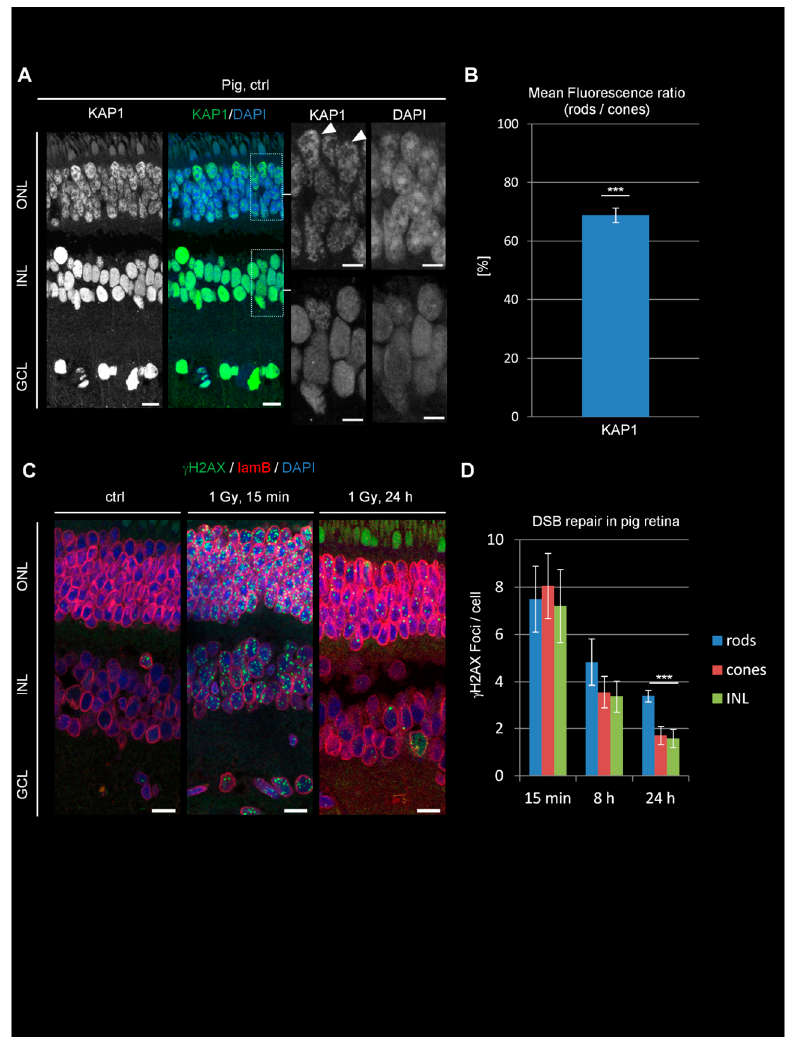
Figure 3. KAP1 expression and DSB repair in pig retinae. ( A ) Immunofluorescence images of KAP1 (green) in pig retinae. Nuclei were counterstained with DAPI (blue). Arrowheads in the enlarged pictures show cone PRs. Scale bars represent 10 μ m in whole retina and 5 μ m in enlarged pictures. ( B ) Quantification of the KAP1 signal in the nuclei of rods compared to cones. ( C ) Immunofluorescence images of radiation-induced γ H2AX foci (green) and lamin B (red) in ctrl and irradiated pig retinae at 15 min and 24 h after 1 Gy. Nuclei were counterstained with DAPI (blue). Scale bars represent 15 μ m. ( D ) Quantification of residual IR-induced γ H2AX foci in rods, cones, and INL cells at 15 min, 8 h, and 24 h after 1 Gy irradiation. Data are presented as mean ± SEM from three experiments ( n = 3). Control values are subtracted. p -values were obtained by t test and represent a comparison of all cells analyzed in the indicated cell population (at least 20 cells per data point and experiment for foci quantification and 10 nuclei for KAP1 fluorescence measurements in rods and cones) with ***: p < 0.001. ONL = outer nuclear layer, INL = inner nuclear layer, GCL = ganglion cell layer, lam B = lamin B.